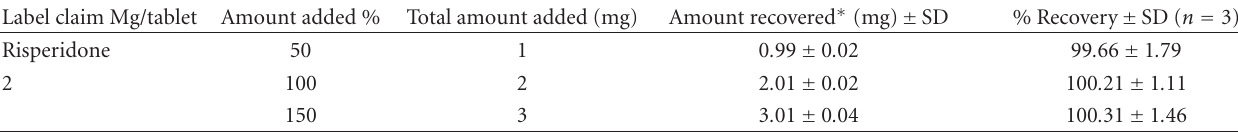
Table 2: Recovery